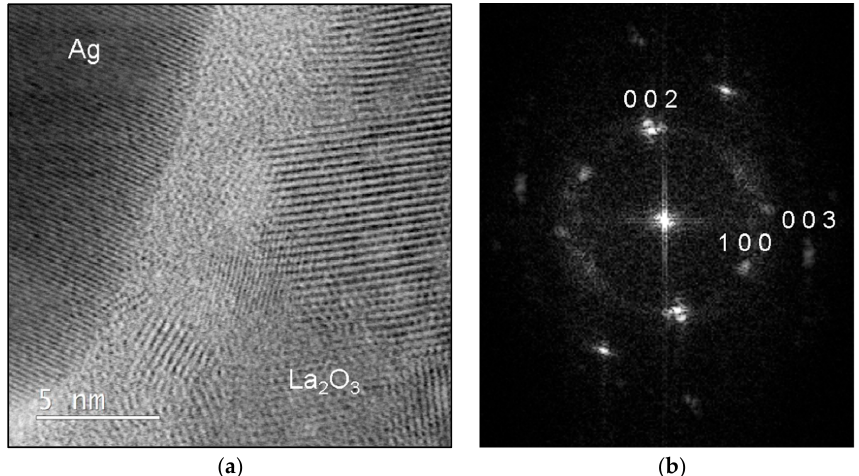
Figure 10. STEM analysis of the internally oxidised ribbons: ( a ) bright ‐ field image of the interface be ‐ tween the α Ag and La 2 O 3 ; ( b ) corresponding FFT pattern from the bright ‐ field image of the La 2 O 3 oxide.